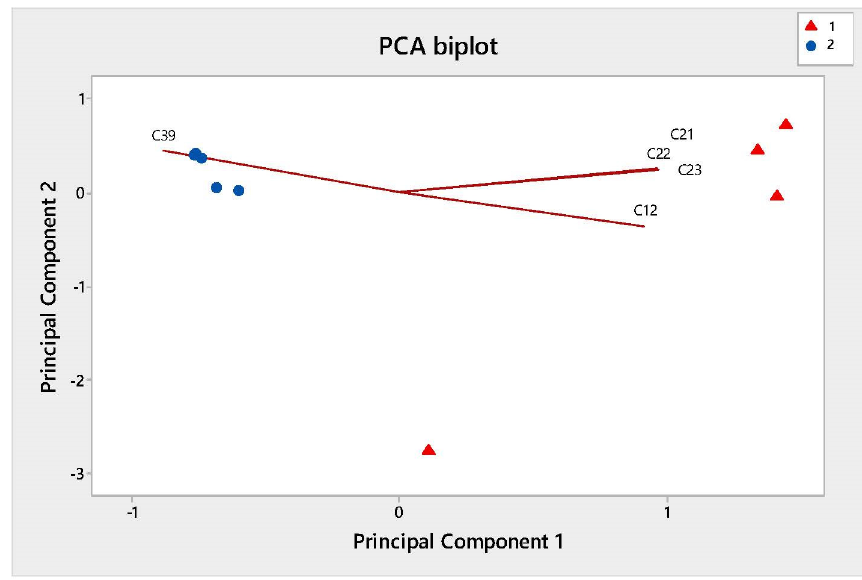
Figure 4. PCA plot regarding the groups of healthy and infected by AFB brood samples .